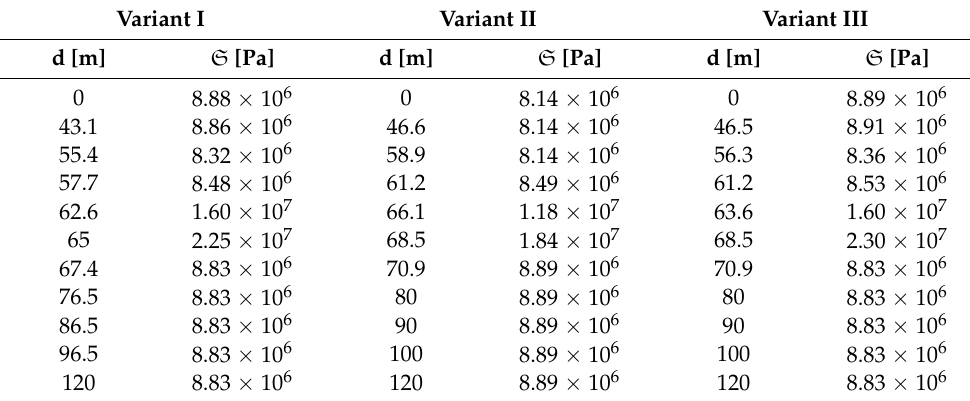
Table 6. Distribution of pressure in the rock mass models in relation to the distance specified concerning the coal face for the considered calculation